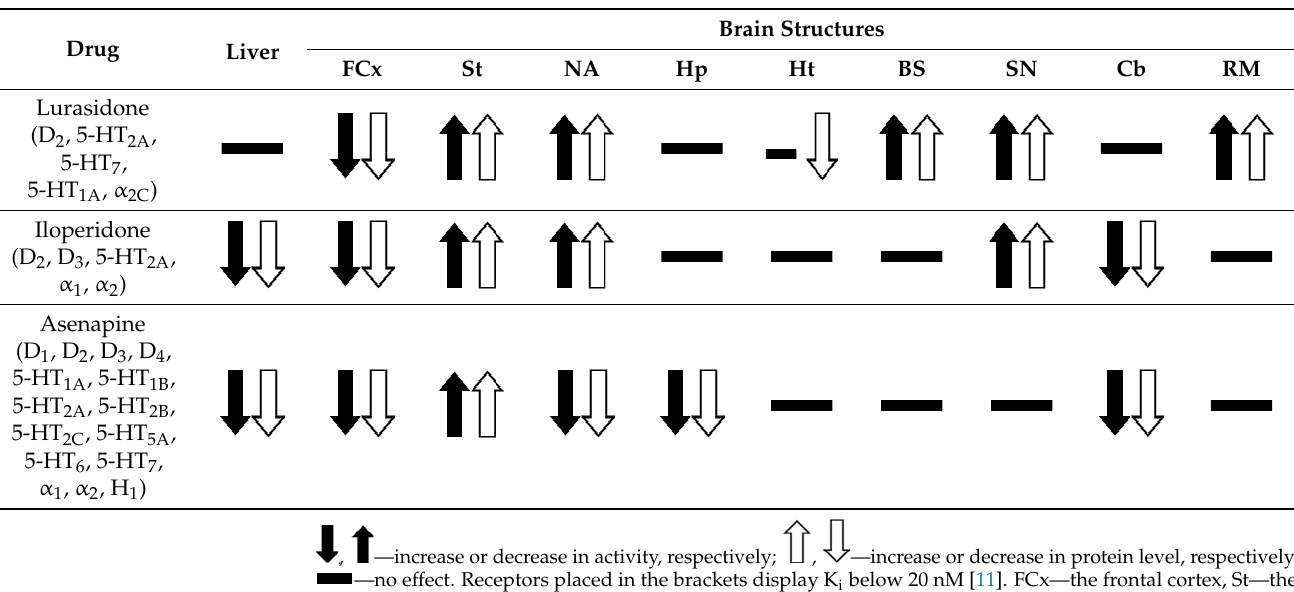
Table 2. The effects of novel atypical neuroleptic drugs on the CYP2D activity and protein level in the liver and brain.